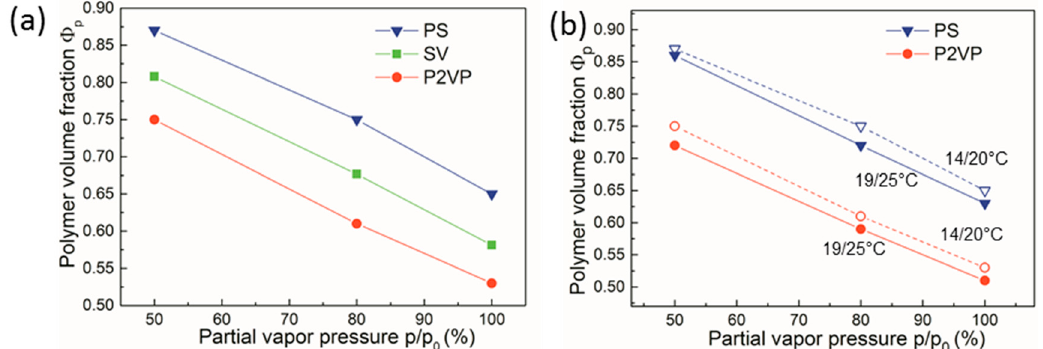
Figure 7. Polymer volume fraction Φ p of PS-PVP (SV), PS, and poly(2-vinyl pyridine) (P2VP) films with a dry thickness of ~40 nm upon stepwise increase of p / p 0 of chloroform: ( a ) in swollen PS-PVP (green squares), PS (blue triangles), and P2VP (red dots) films all at a temperature set T v / T s of 14 ◦ C / 20 ◦ C; ( b ) in swollen PS (blue) and P2VP (red) films at T v / T s = 14 ◦ C / 20 ◦ C (empty symbols, dashed line) and at T v / T s = 19 ◦ C / 25 ◦ C (solid symbols, solid lines). Φ p is calculated from the measurements of the dry and the swollen film thicknesses as h dry / h sw .